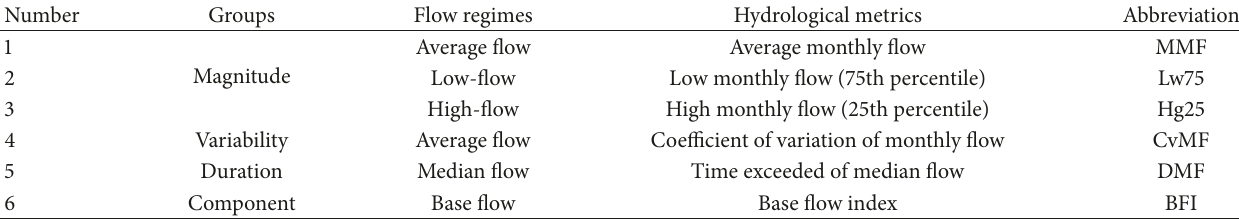
Table 1: The flow regime metrics selected to describe streamflow